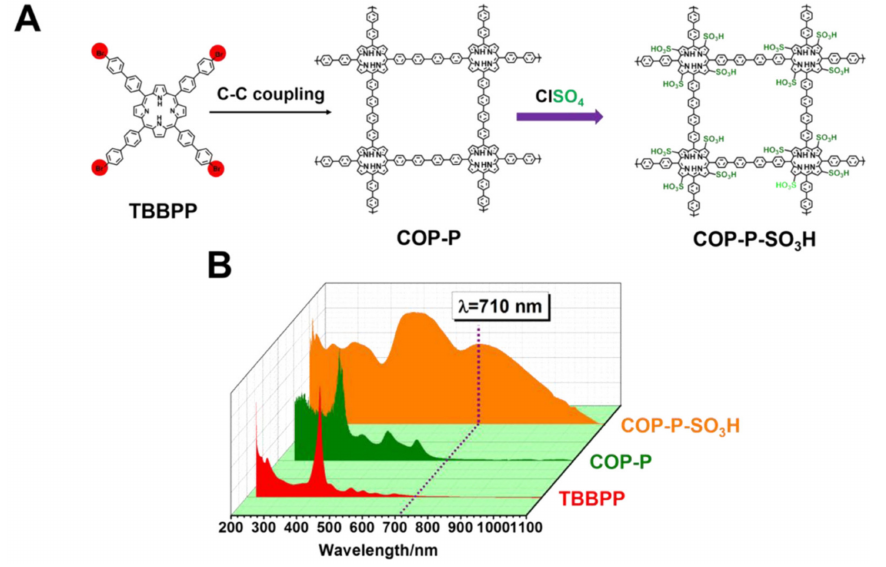
Figure 2. ( A ) Strategy for the formation of the two-dimensional porphyrin-based conjugated polymer for photodynamic therapy; ( B ) UV–Vis spectra of the aqueous solution of substrate and products. Reprinted with permission from [50]. Copyright (2016) American Chemical Society.